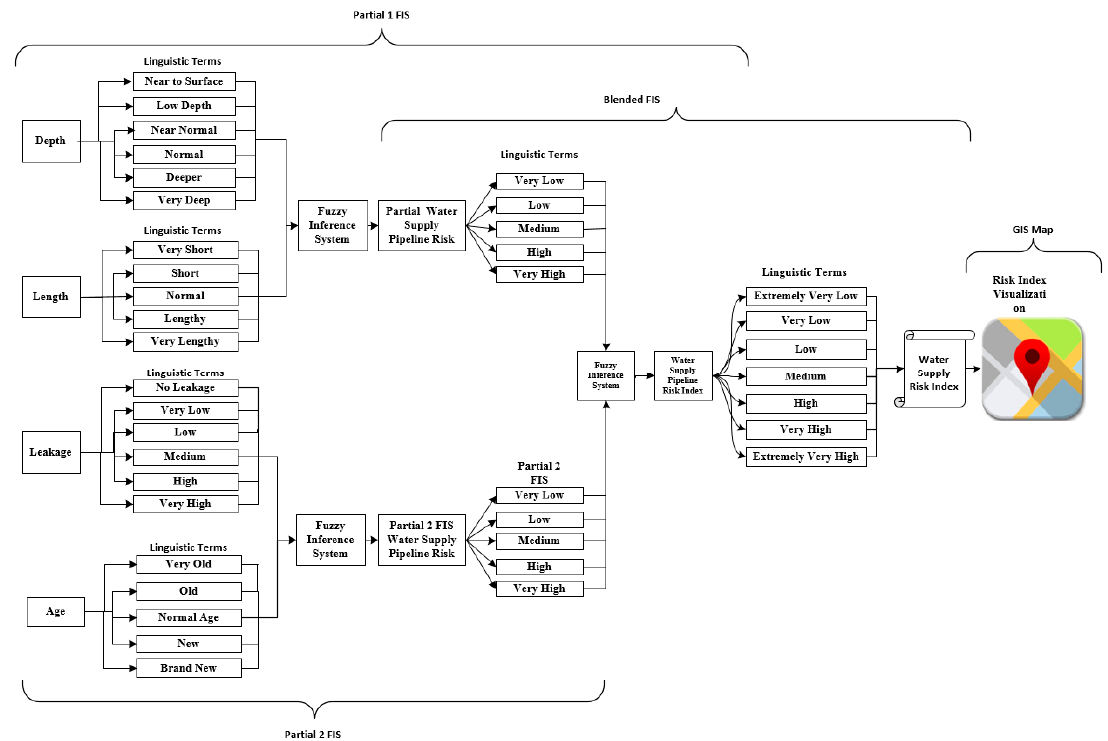
Figure 6. Detailed representation of the blended hierarchical fuzzy risk index visualization model for water supply pipelines.